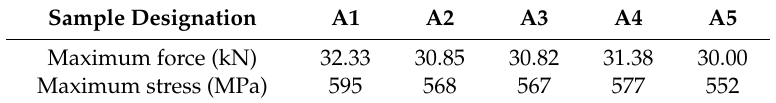
Figure 11. Cracks on flat side surface of sample C4. Table 1. Maximum force and stress values recorded for reference samples—group A.